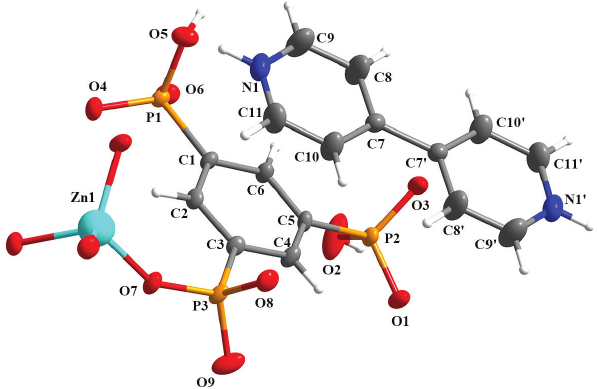
Table 2: Fractional atomic coordinates and isotropic or equivalent isotropic displacement parameters (Å 2